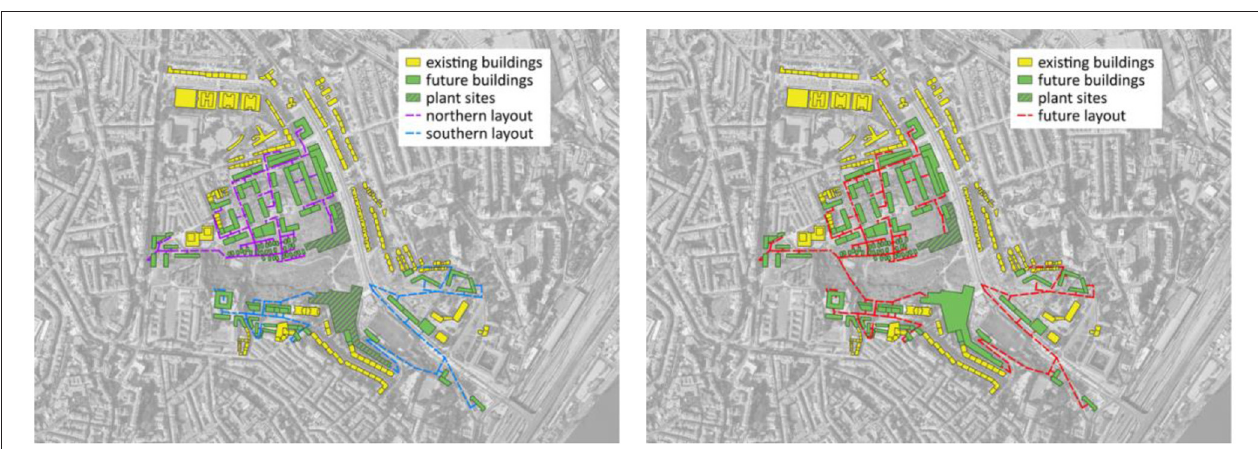
FIGURE 6 | Energy demand intensity per end-uses for selected buildings.